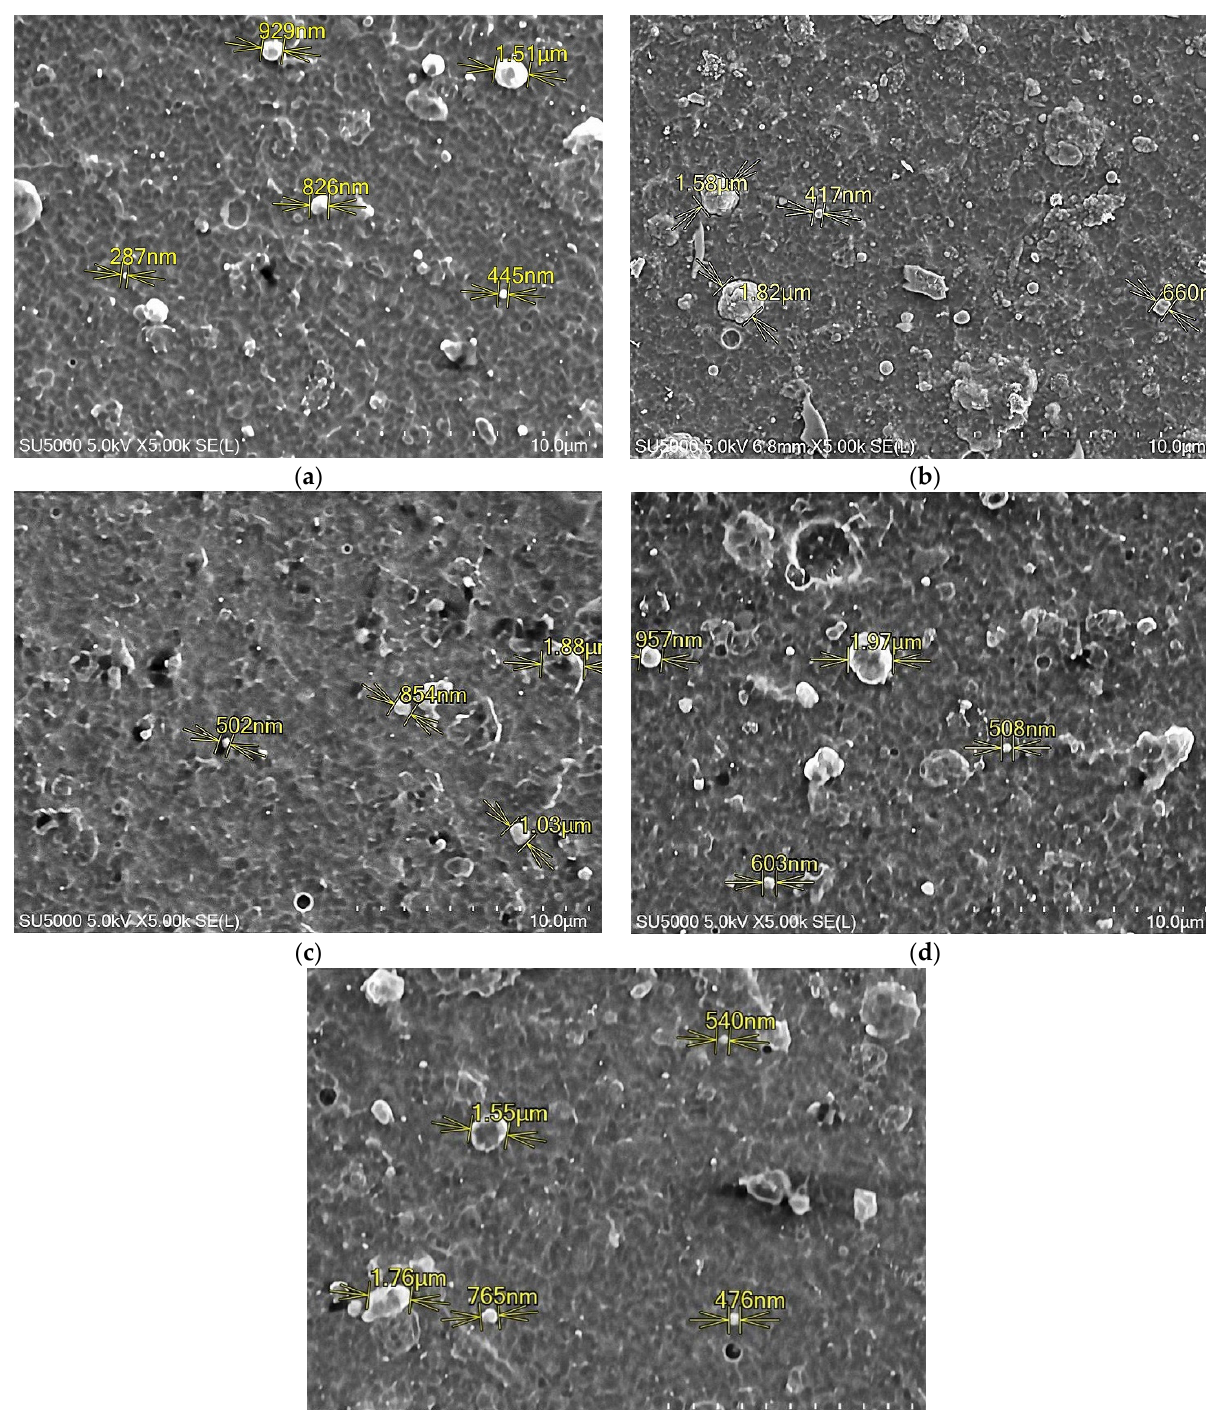
Figure 3. SEM images of CrAlSiN-AlSiN surface: ( a ) as-deposited; and after thermal treatment ( b ) 600 ◦ C, ( c ) 700 ◦ C, ( d ) 800 ◦ C, and ( e ) 900 ◦